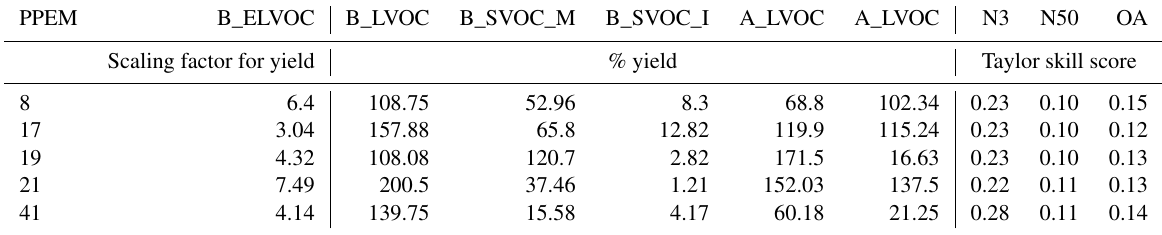
Table A2. Scaling factor for B_ELVOC and yields of other ox-VOCs with the corresponding Taylor skill scores for five ensemble members that are shaded red for all three outputs N3, N50, and OA in Fig.